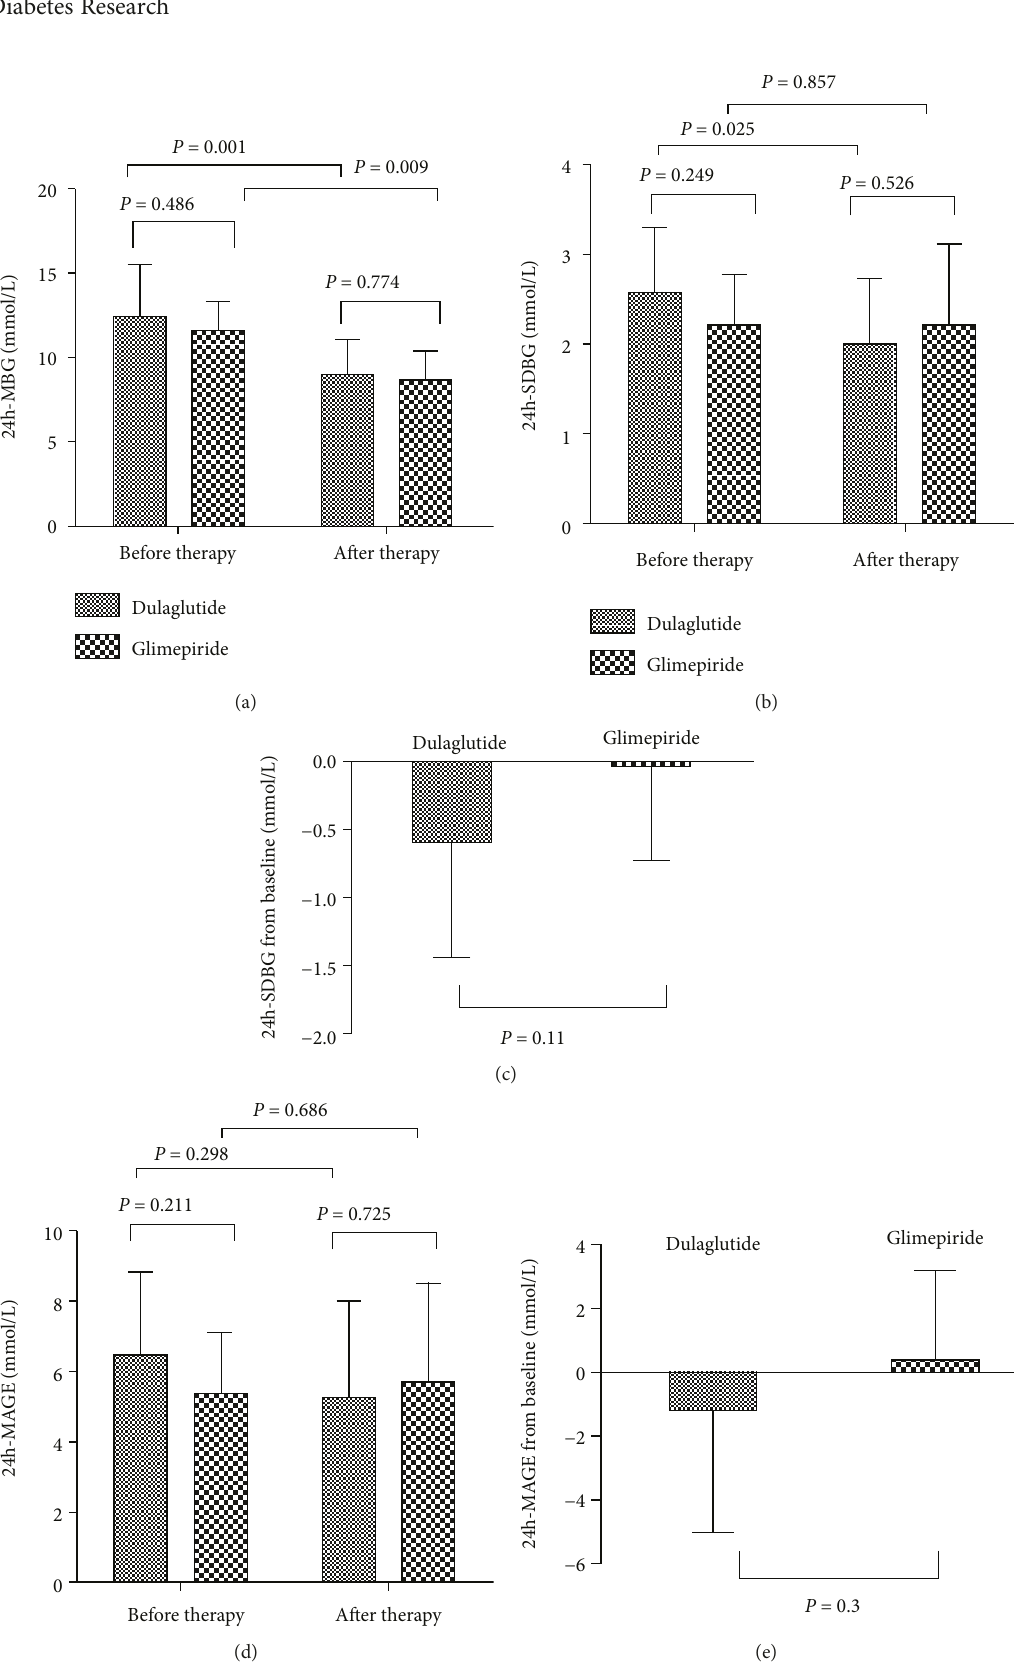
Figure 3: Comparisons of CGMS glucose parameters: (a) 24h-MBG, (b) 24h-SDBG, (c) 24h-SDBG, (d) 24h-MAGE, and (e) 24h-MAGE at baseline and after treatment in the dulaglutide and glimepiride